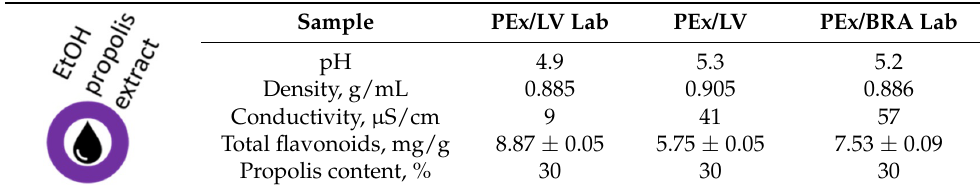
Table 3. Properties of ethyl alcohol propolis extracts.